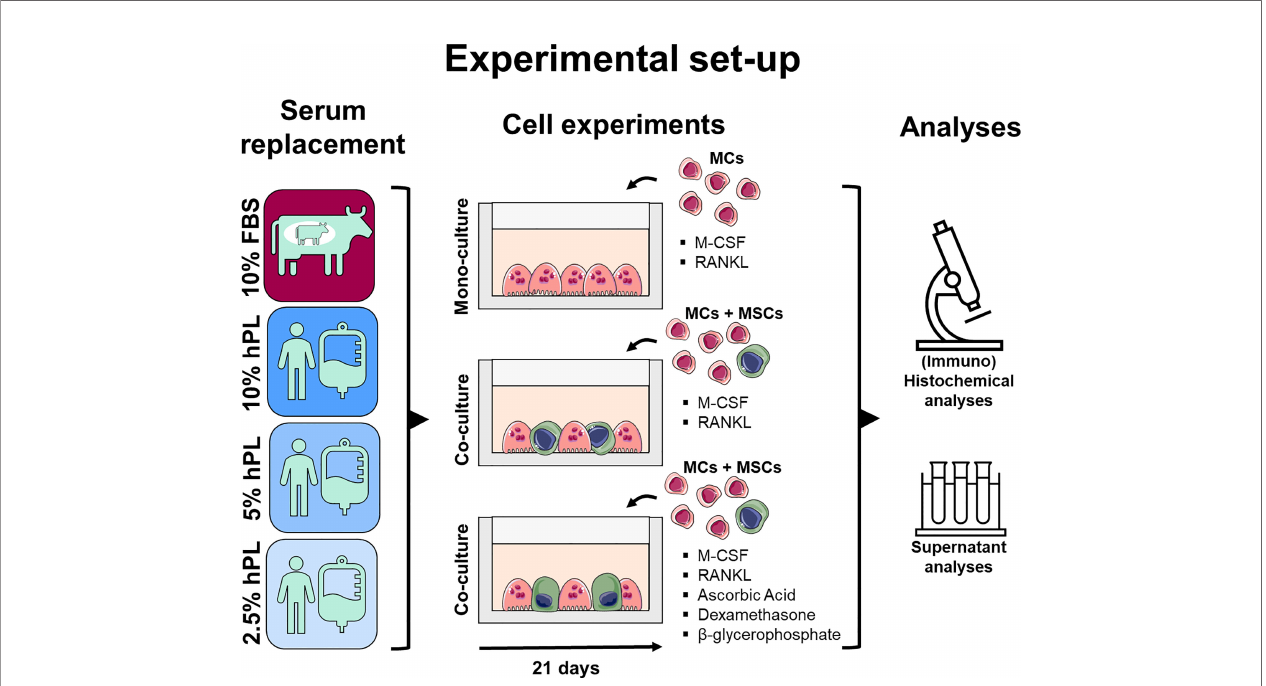
FIGURE 1 | Medium supplementation with 10%, 5%, and 2.5% hPL were compared with 10% FBS for MC mono-cultures and (osteogenically stimulated) MC-MSC co-cultures. Cell cultures were analyzed using (immuno)histochemical and (immuno)cytochemical analyses to assess resorption, cell markers and cell morphology, and supernatant analyses to measure osteoclast activity and secreted RANKL and OPG. The fi gure was modi fi ed from Servier Medical Art, licensed under a Creative Common Attribution 3.0 Generic License (http://smart.servier.com/, accessed on 8 July 2021). fetal bovine serum (FBS), human platelet lysate (hPL), monocytes (MCs), mesenchymal stromal cells (MSCs), macrophage colony-stimulating factor (M-CSF), receptor activator of nuclear factor k B ligand (RANKL), osteoprotegerin